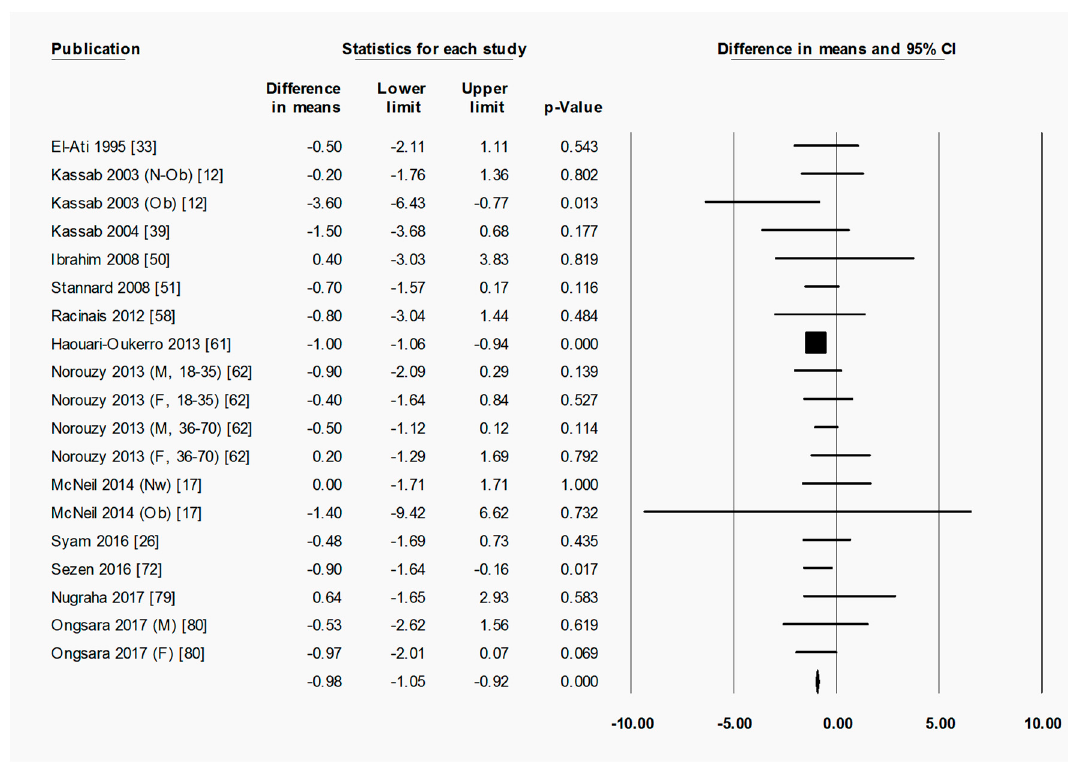
Figure 5. Absolute fat mass was significantly decreased by Ramadan fasting. Change in absolute fat mass (kg) between pre-Ramadan (pre-R) and the end of Ramadan (post-R). Heterogeneity statistics: T = 0.000, p = 0.600, I 2 = 0.0%. F = female; M = male; Nw = normal weight; Ob = obese; N-Ob = non-obese; 18–35, 36–70 = age range.